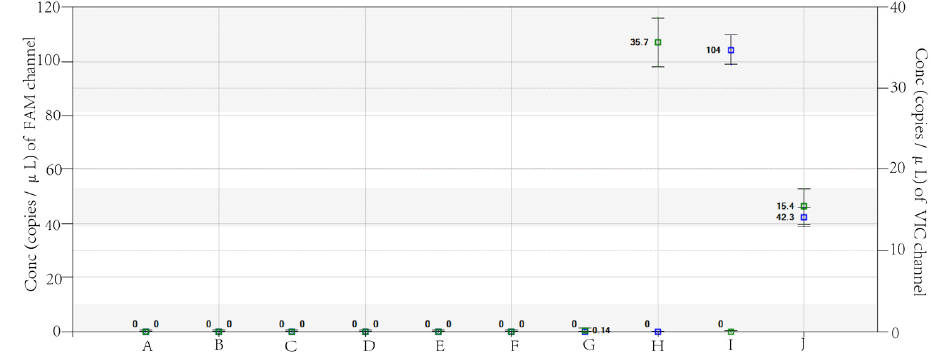
Figure 2. Specific detection results in VIC and FAM channels of dd PCR. Note: The X-axis shows different amplification templates, A represents nuclease-free water, while B–J represent the nucleic acid of H1N1 pdm09, H3N2, B/Victoria, B/Yamagata, H5N1, H9N2, GD003 R294, GD003 R294K, and the mixture of GD003 R294K and GD003 R294, respectively. The Y-axis represents the number of gene copies per microliter of reaction system for FAM and VIC channels.